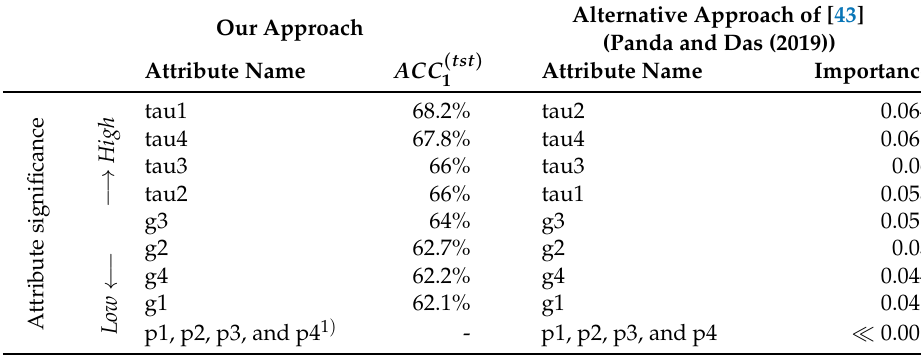
Table 6. Final hierarchy of attribute significance—a comparison of our approach and an alternative method of [43] ( Electrical Grid Stability Simulated Data Set